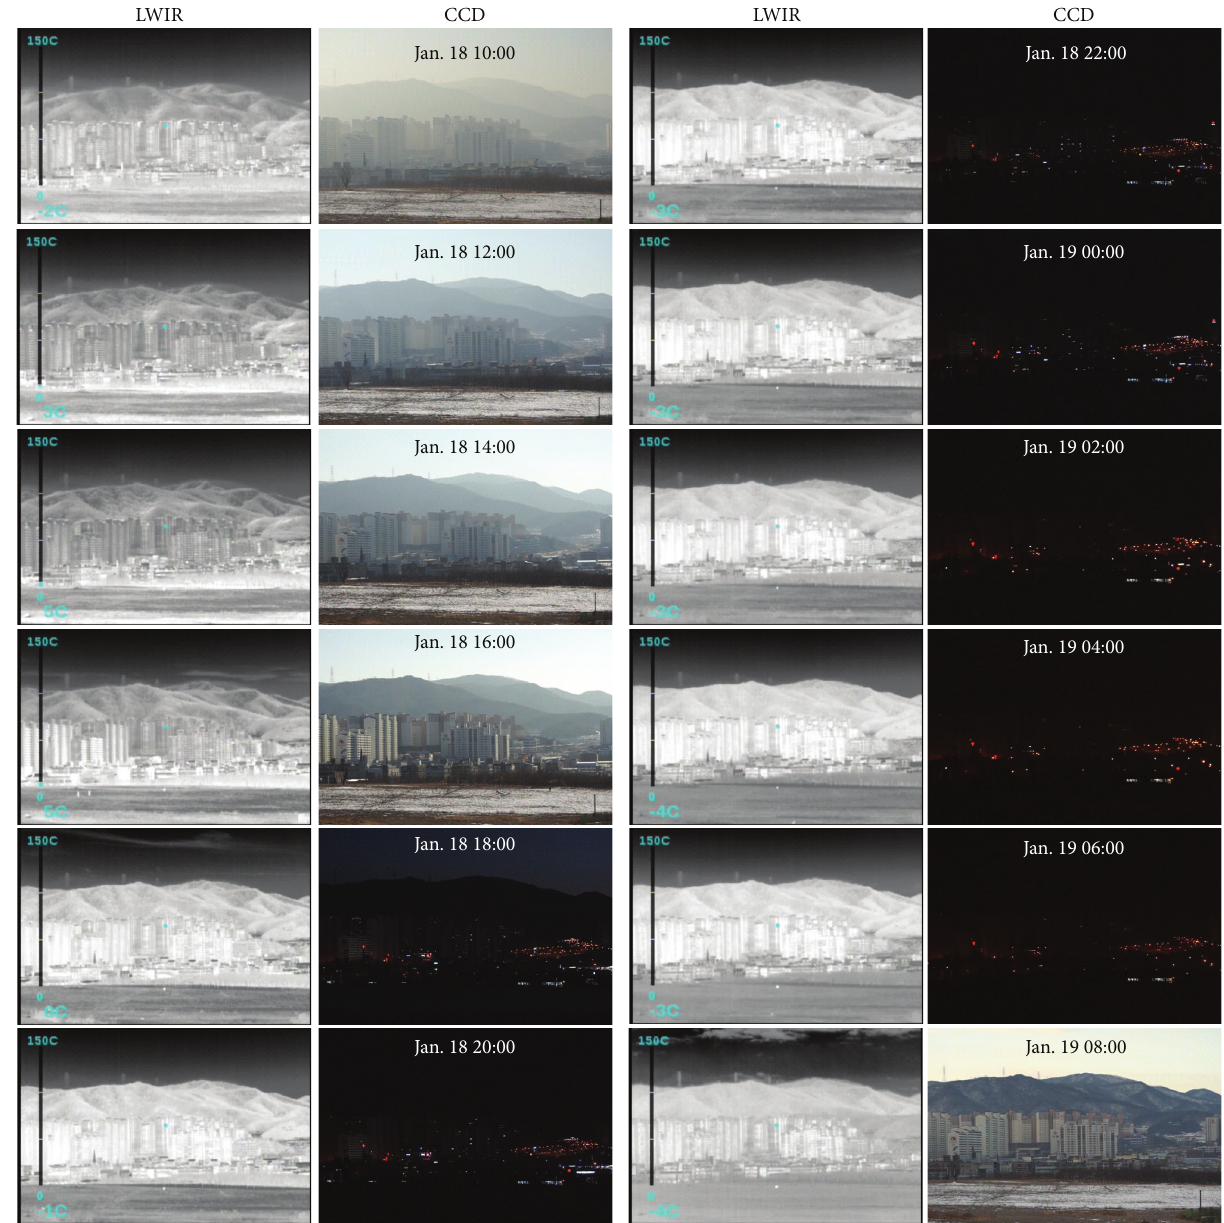
Figure 8: Partial examples of the acquired LWIR and CCD images over 24-hour period in